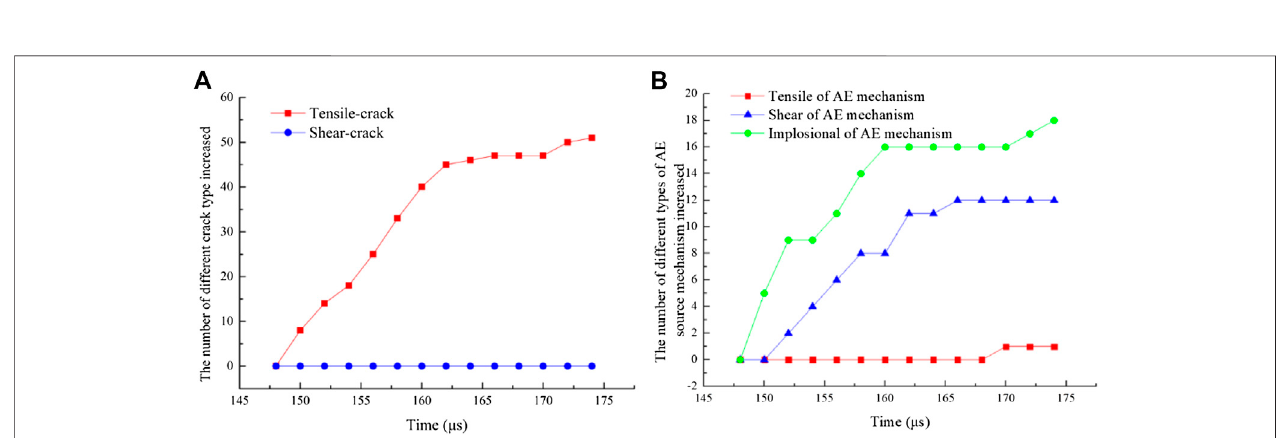
FIGURE13| Thestatisticalresultsofdifferenttypesofmicro-crack. (A) isthenumber ofdifferentcracktypes increasedfrom148to173 μ sobtainedbyPFC. (B) is the number of different types of AE source mechanisms increased from 148 to 173 µs.